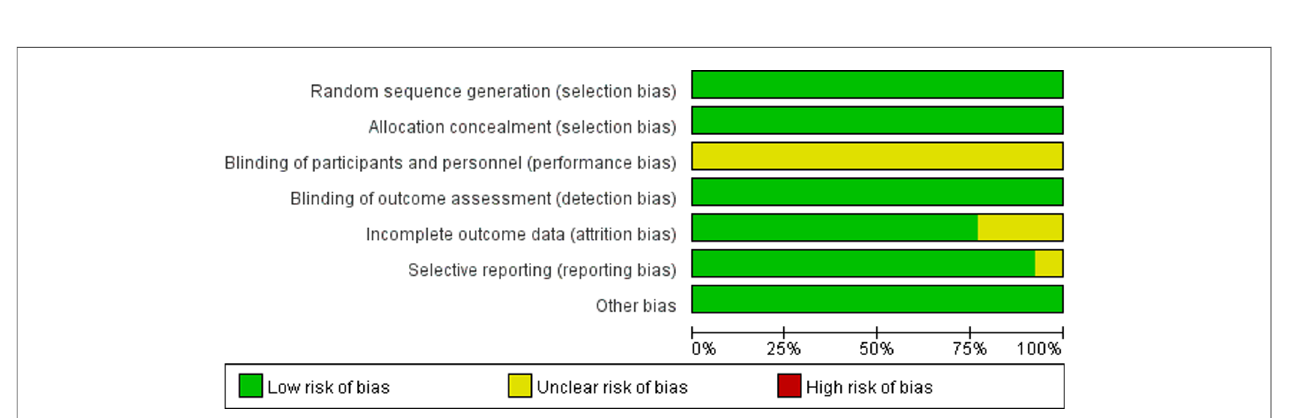
FIGURE 2 | Risk of bias graph according to the Cochrane collaboration ’ s